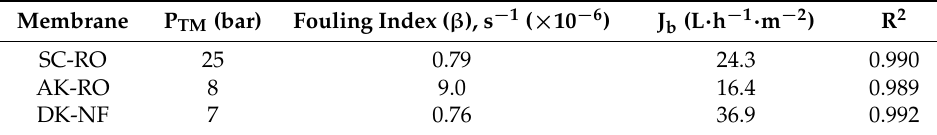
Table 6. Fouling indexes and boundary flux for semibatch membrane